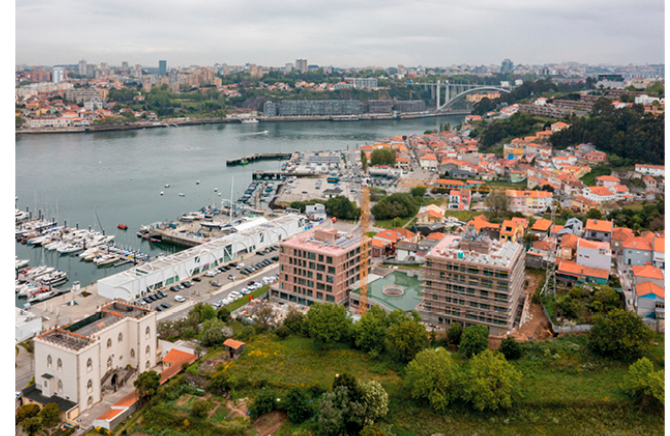
Figure 5. Vila Nova de Gaia. Aerial view.